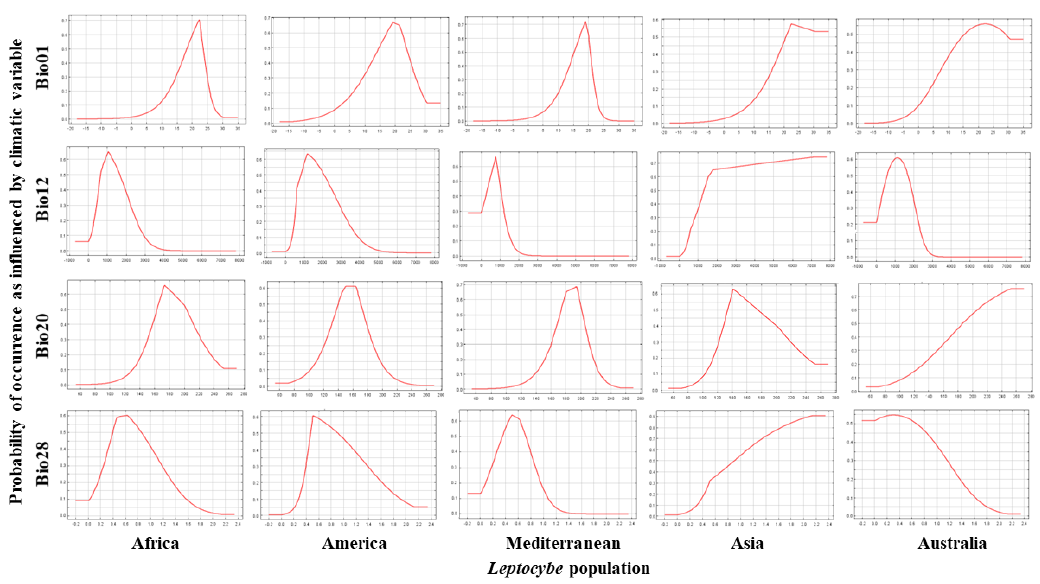
Figure 4. MaxEnt-predicted response curves for probability of occurrence of Leptocybe populations determined by Bioclim variables (Bio01= annual mean temperature (°C); Bio12 = annual precipitation (mm); Bio20 = annual mean radiation (W m −2 ); Bio28 = annual mean moisture index). The y-axes denote the probability of occurrence (range 0 to 0.5 or 0.7) while the x-axes denote the range of the variable (range Bio01: −20 to 35; range Bio12: −1000 to 8000; range Bio20: 60 to 280; range Bio28: −0.2 to 2.4).